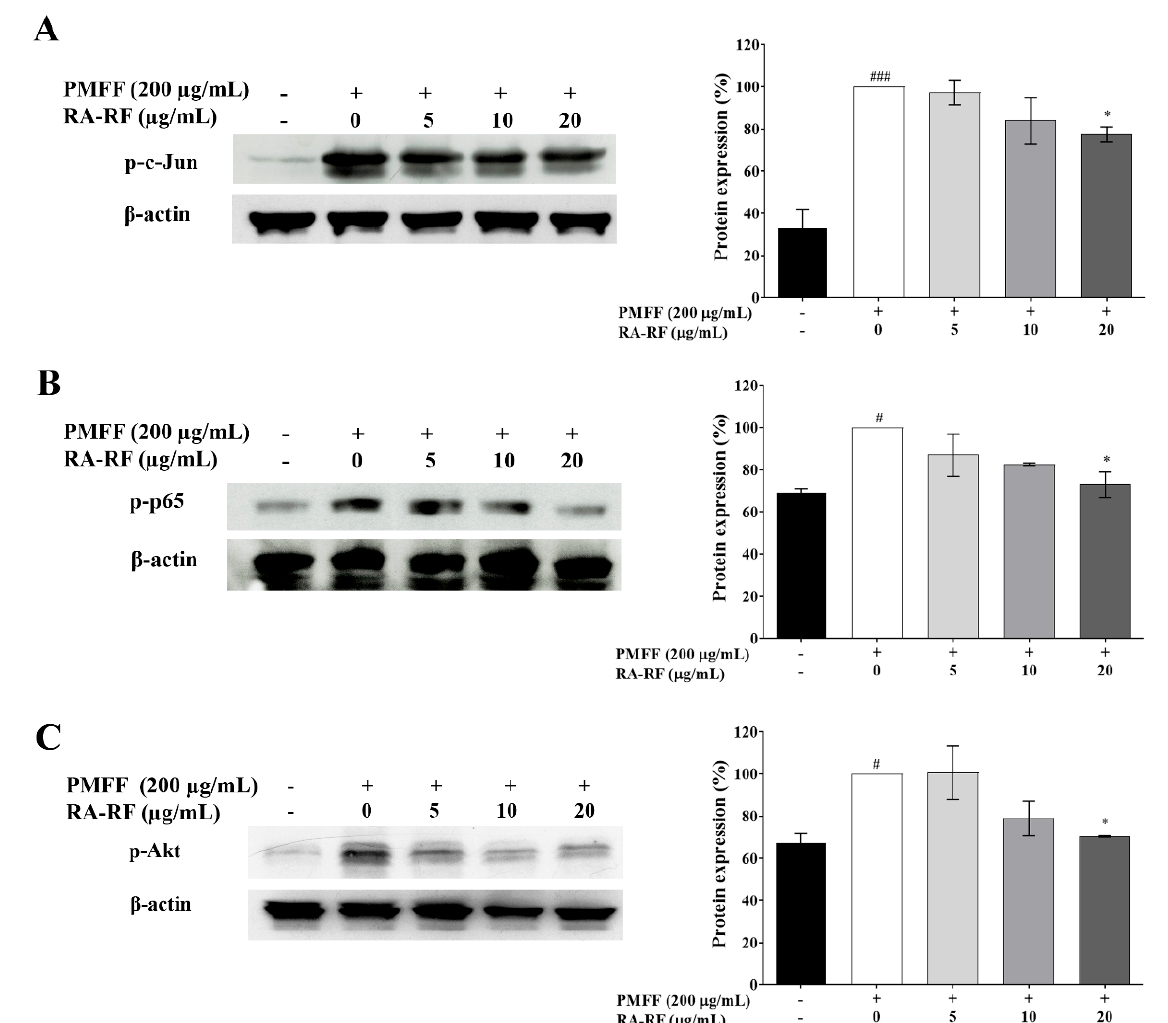
Figure 5. The protein expression of p-c-Jun ( A ), p-65-NF- κ B ( B ), and p-Akt ( C ) in A549 cells exposed to PMFF (200 µ g/mL) in the presence of RA-RF (5, 10, and 20 µ g/mL) determined by Western blot analysis. Error bars indicate SD. The mean ± SEM are shown as # p <0.05, ### p < 0.001 vs. the control group; * p < 0.05 vs. PMFF group. The data were independently performed in triplicate.